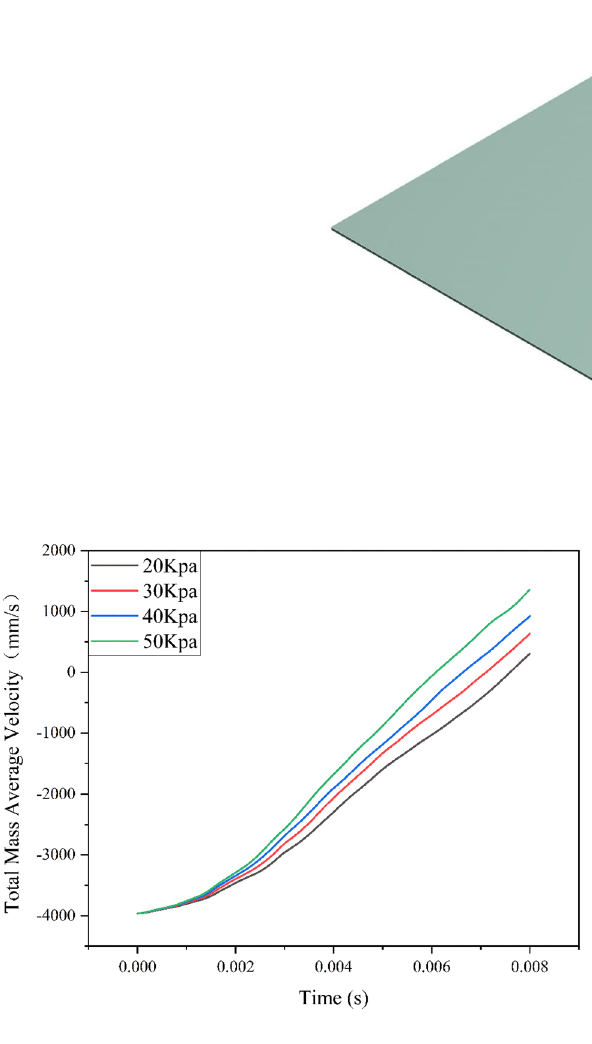
Fig. 7 Velocity change curve in Y-axis direction of